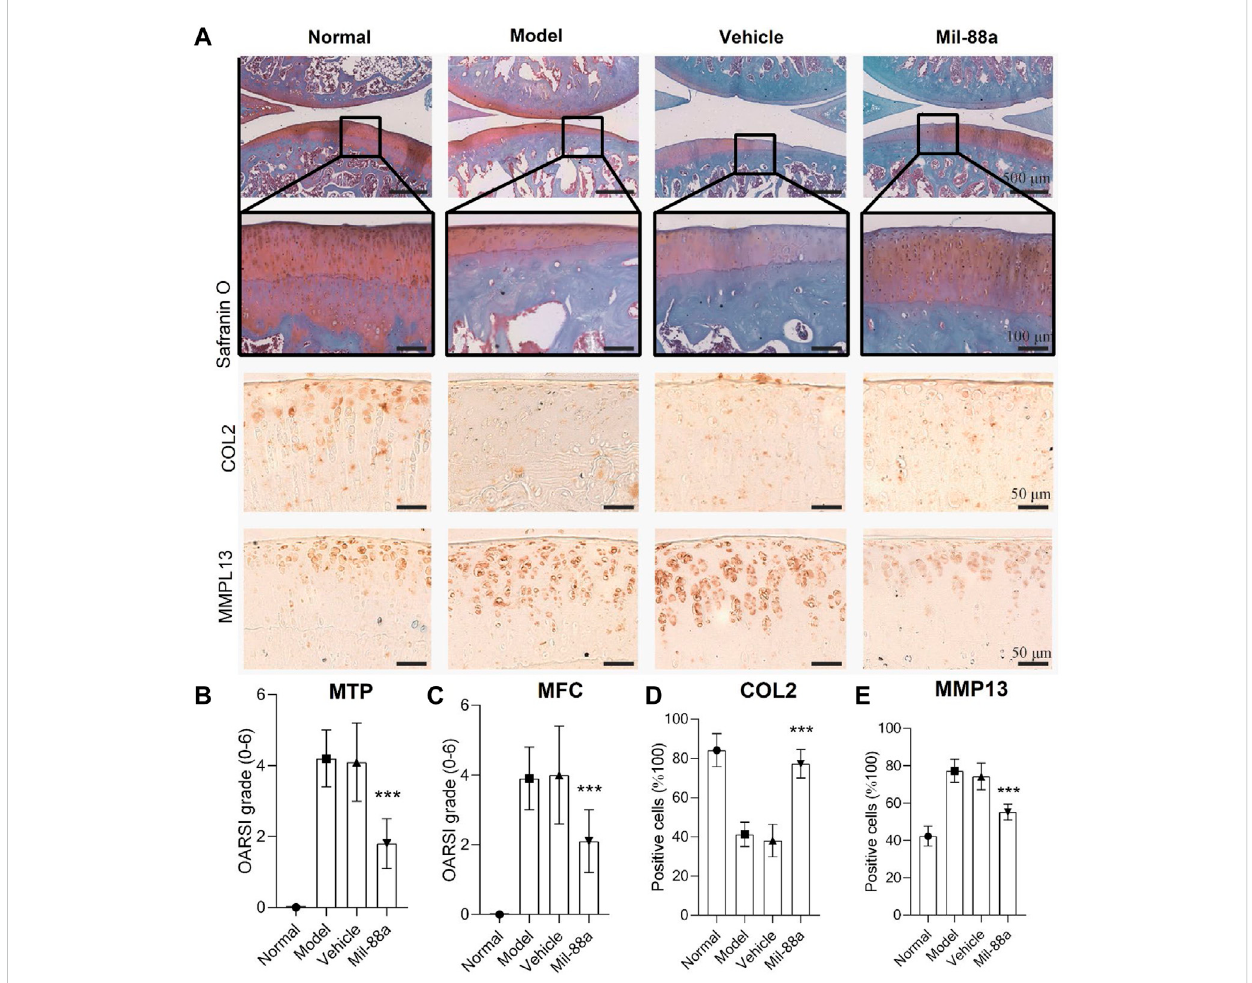
FIGURE 3 Mil-88aalleviatesthepathologicalmanifestationsofOA. (A) SafraninOstainingofparaf fi nsectionsofratkneetissue,scalebar=500or100 μ m,and immunohistochemical staining of Col2 and MMP13, scalebar = 50 μ m. (B, C) OARSI score. (D, E) Positivecell statistics of Col2 and MMP13. ( n = 6). ns, no statistical difference; p p < 0. 05; pp p < 0. 01; ppp p < 0.